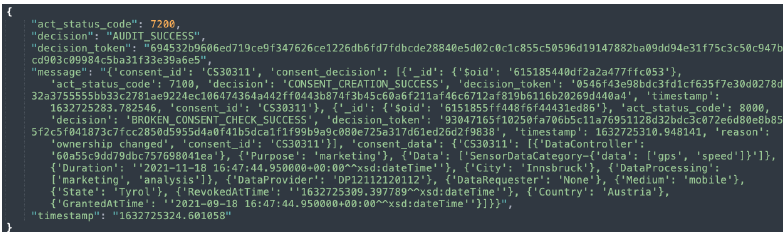
Figure 12. Sample response to a request for full auditing based on